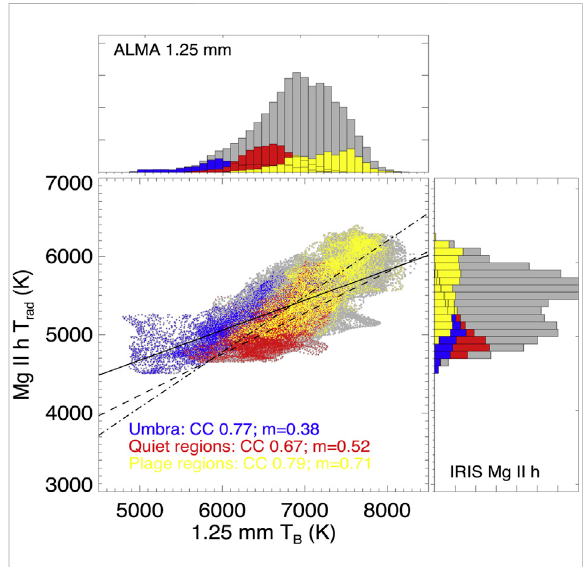
FIGURE 6 AscatterplotofIRISMgIIhlineradiationtemperaturesversus the ALMA 1.25 mm brightness temperatures together with the corresponding histograms. Gray points represent all pixels; blue points for the umbra; red for the quiet-Sun areas; and yellow for the plage. Linear fi ts to pixels in the umbra, quiet, and plage pixels are shown with a solid, dashed, and dotted – dashed line, respectively. From Bastian et al. (2018). Reproduced by permission of the